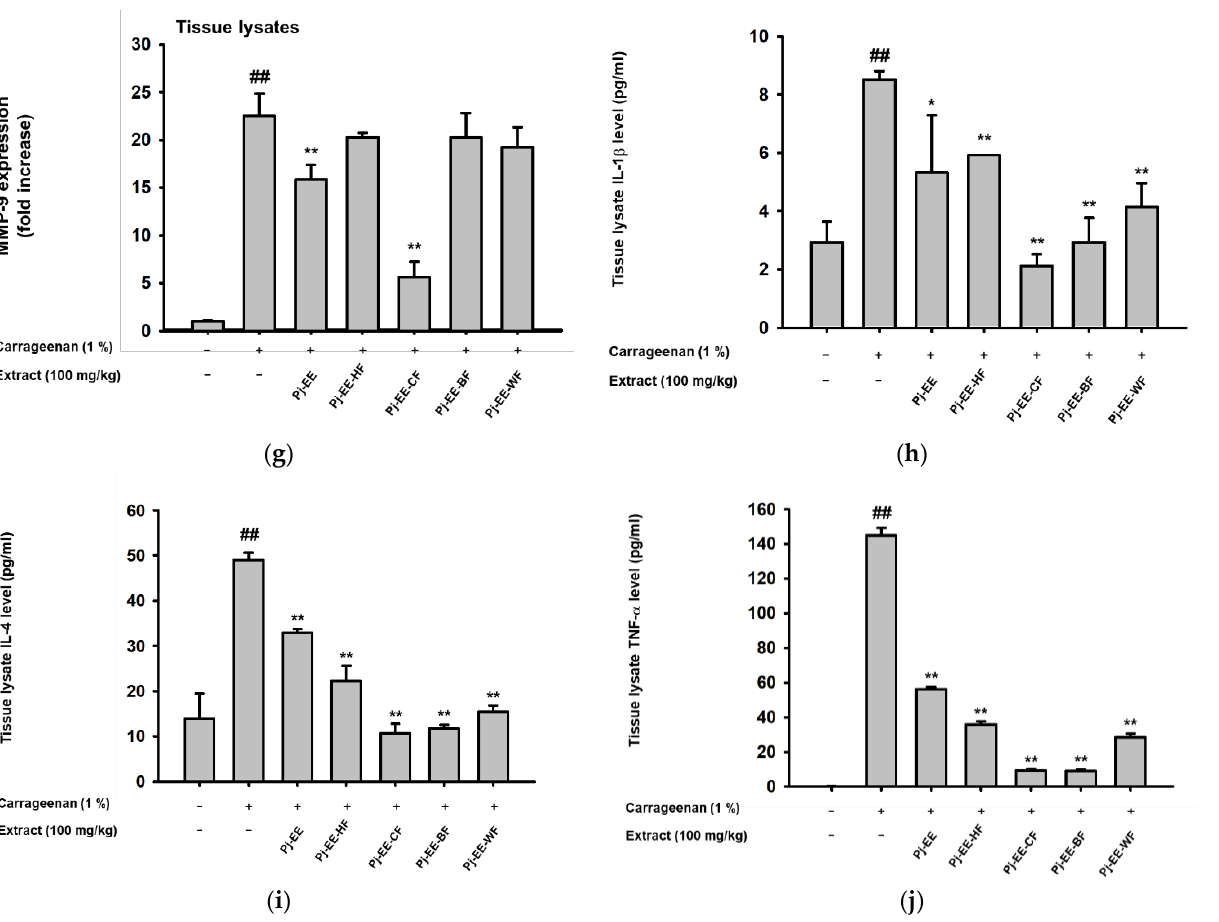
Figure 5. Effects of Pj-EE and four solvent fractions (HF, CF, BF, and WF) on the pro-inflammatory genes and cytokines production in carrageenan-induced acute paw edema models. ( a – g ) The expression of inflammatory genes, including iNOS ( a ), COX-2 ( b ), TNF-α ( c ), IL-6 ( d ), IL-1β ( e ), MMP-2 ( f ), and MMP-9 ( g ) from paw lysates was measured by quantitative real-time PCR. ( h – j ) Supernatant IL-1β ( h ), IL-6 ( i ), and TNF-α ( i ) levels of tissue lysates on carrageenan-triggered paw edema were examined by EIA. All of the data are expressed as mean ± standard deviation ( n = 6). ## p < 0.01 compared to the normal group, and * p < 0.05 and ** p < 0.01 compared to the control group (inducer alone) by one-way ANOVA.